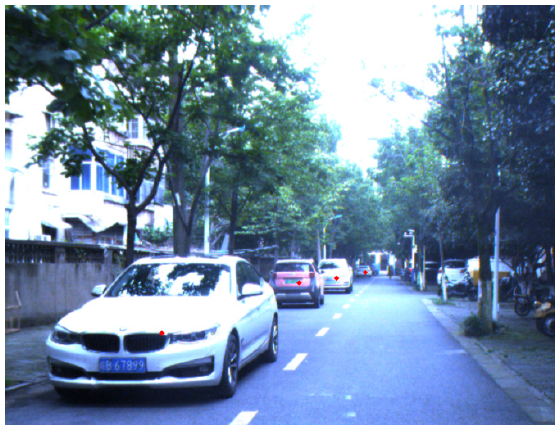
Figure 5. Radar detection target is projected on the image.